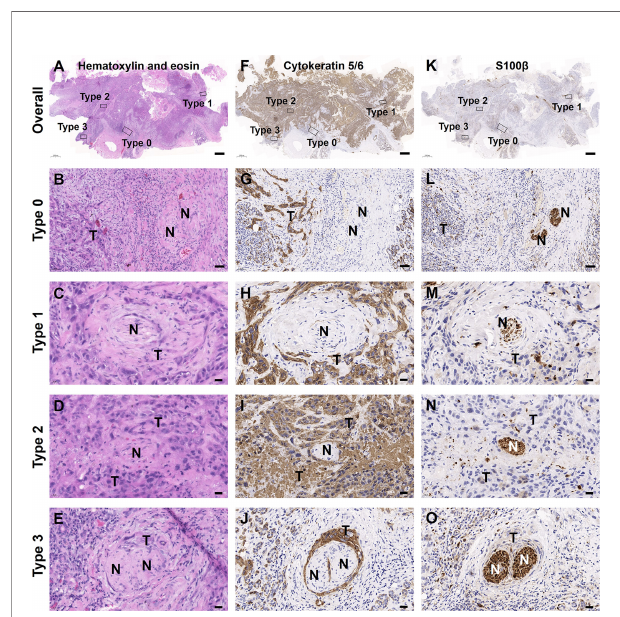
FIGURE 2 | Mixed PNI types simultaneously occurred in one OSCC sample. (A – E) H&E images. (F – J) Tumor cells labeled with cytokeratin 5/6. (K – O) Nerves labeled with S100 b . The bold “ T ” and “ N ” represented tumor cells and nerves, respectively. Scale bars: (A , F , K) 1,000 m m, (B , G , L) 50 m m, and (C – E , H – J , M – O) 20 m